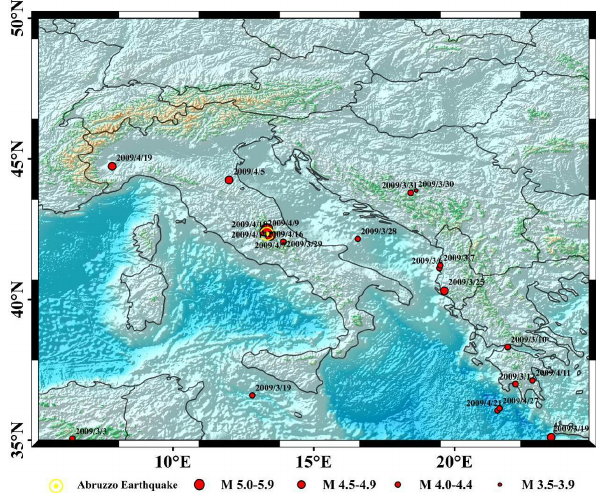
Figure 1. Historic seismicity (from March 2009 to April 2009) of Abruzzo region. The 2 Fig. 1. Historic seismicity (from March 2009 to April 2009) of the Abruzzo region. The epicentre of the Abruzzo earthquake that oc- epicenter of Abruzzo earthquake occurred on 6 April 2009 is marked with a yellow cride.3 curred on 6 April 2009 is marked with a yellow